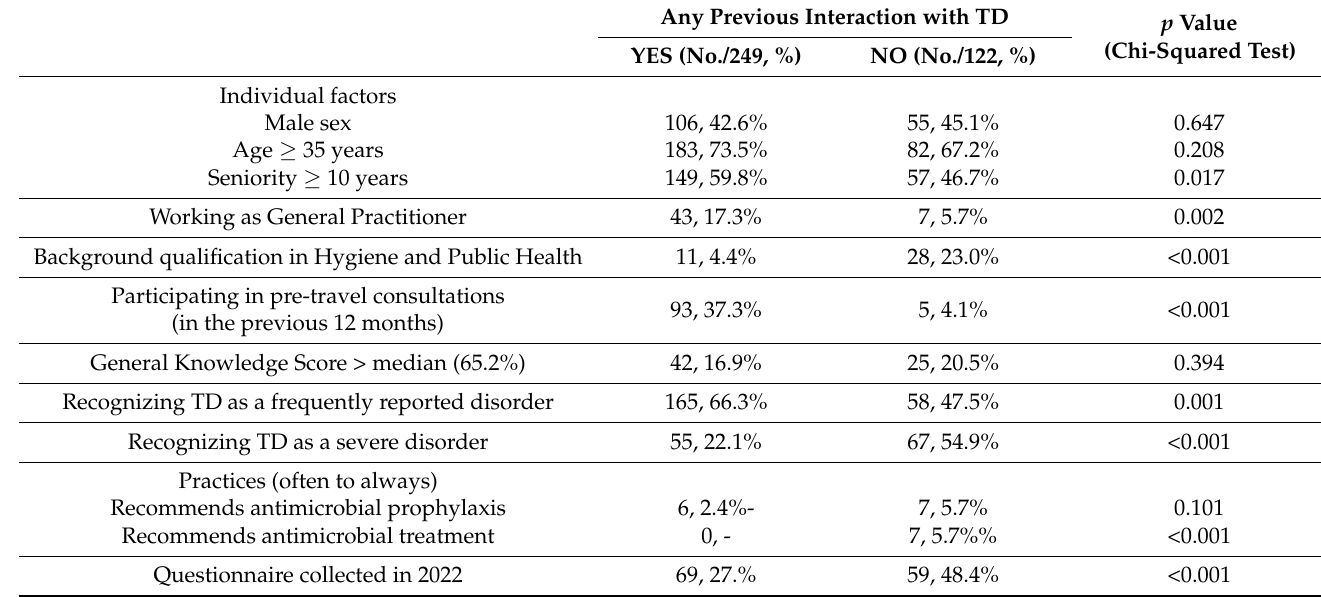
Table A3. Univariate analysis of individual factors associated with having had any previous experi- ence with TD, either as having been affected by TD of having managed at least one case of TD in the previous 12 months (Note: TD = travelers’ diarrhea ).